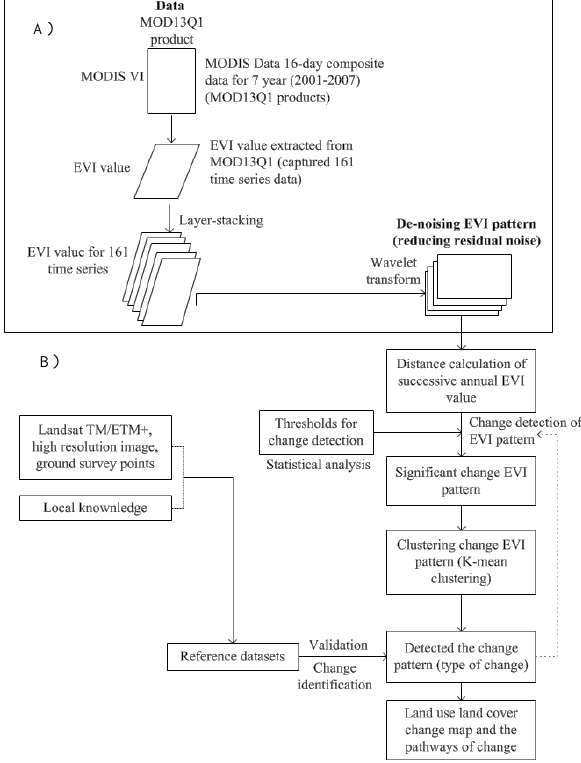
Figure 1. The flow chart of change detection in this study; (A) image preparation and pre-processing (completed by previous study), (B) change detection (this Figure 2 indicates that the wavelet transform application deals with discontinuous /sharp spike data (as a residual noise). Once the filtering applied on the temporal EVI pattern, the vegetation phenology can be defined more clearly. Figure 3 shows the result image of filtering by wavelet function on a MODIS image.